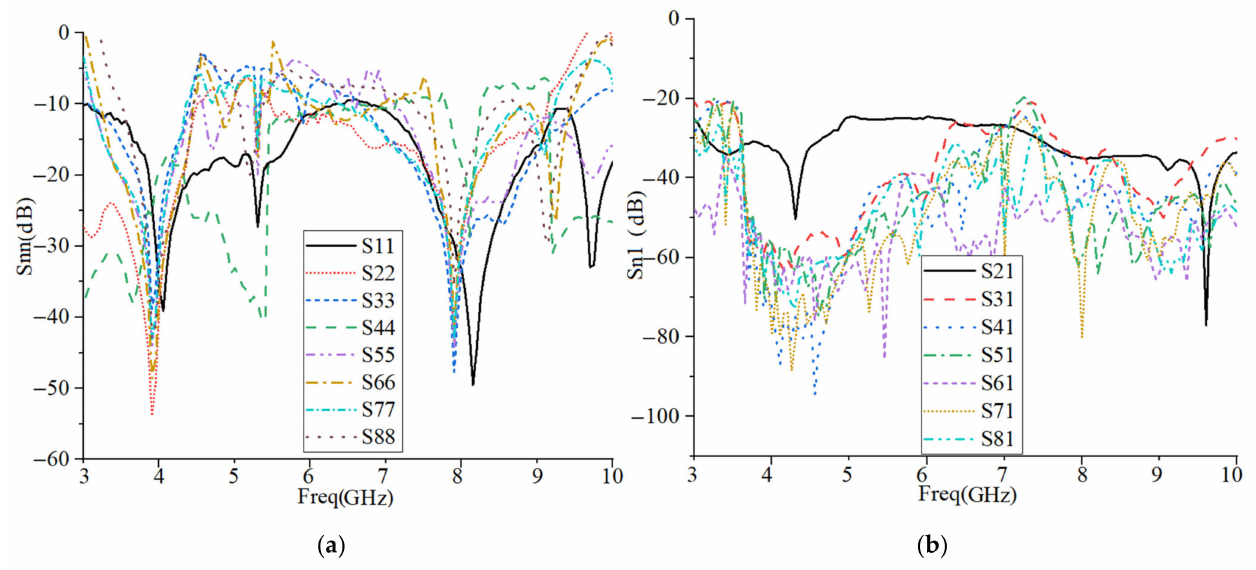
Figure 19. Measured: ( a ) reflection and ( b ) transmission coefficients of the MIMO